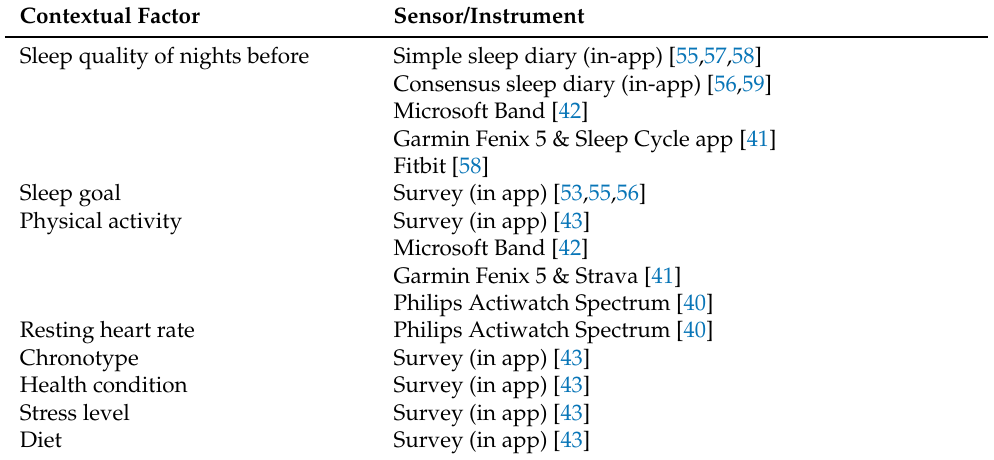
Table 2. Contextual factors and measurement